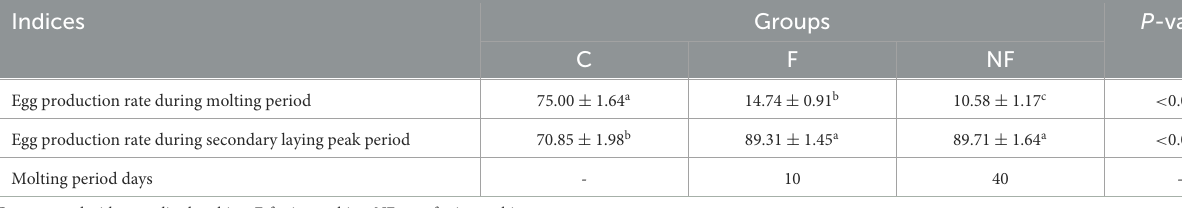
TABLE 2 Effects of non-fasting molting on the performance of laying hens. Indices